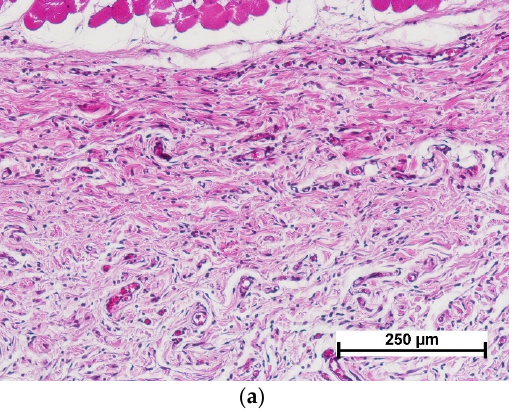
Figure 5. Histological picture—day 14. Comparison of cell-free scaffold ( a , c , e ) and collagen matrix ( b , d , f ). ( a , b )—implant with surrounding tissue, general view, ( c , d )—connective tissue structure surrounding the implant, ( e )—connective tissue at the cell-free scaffold site, ( f )—collagen matrix structure. Staining with hematoxylin–eosin. Note: (1)—connective tissue replacing the scaffold; (2)—connective tissue surrounding the scaffold; (3)—collagen matrix; (4)—connective tissue structure around the implant; (5)—lymphocyte; (6)—granulocyte; (7)—macrophage; (8)—blood vessel; (9)—fibroblast; (10)—fibrocyte.